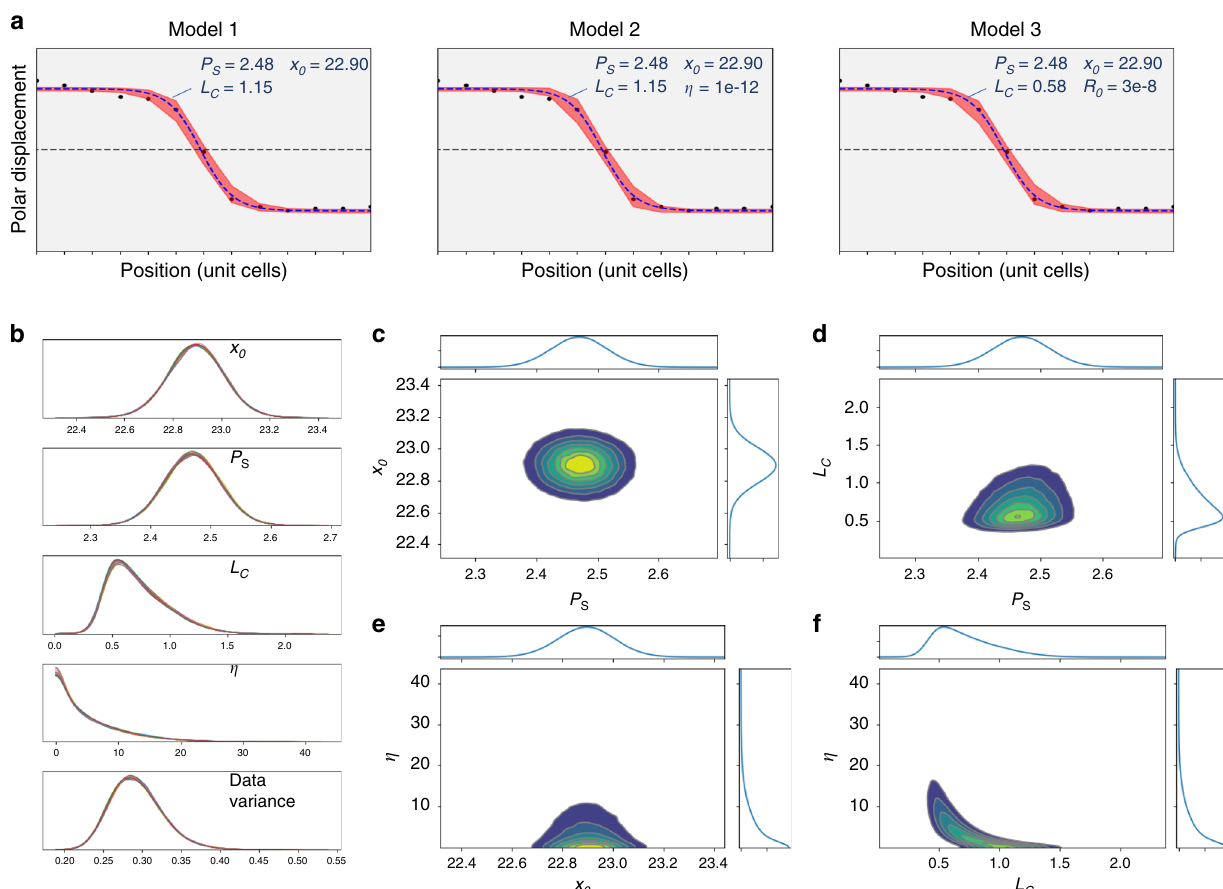
Fig. 3 109° Domain wall: LGD models and posterior probability densities. a The 90% highest posterior density interval for the Bayesian analysis (red band) overlaid on experimental mean values (data points). Dashed blue line is a least square fi t. b Posterior probability densities (PPD) for the Model 2 parameters, Eq. (3b). Shown in b are 1D PPD for wall position, saturation polarization, correlation length, η , and the data variance. c – f are selected 2D joint probability densities for different parameter combinations. Some parameters (e.g., c , d , e ) are clearly marginalizable, whereas the parameters L c – η ( f ) show that probability density is not marginalizable. These joint distributions illustrate how knowledge of one parameter can signi fi cantly enhance the estimate on the